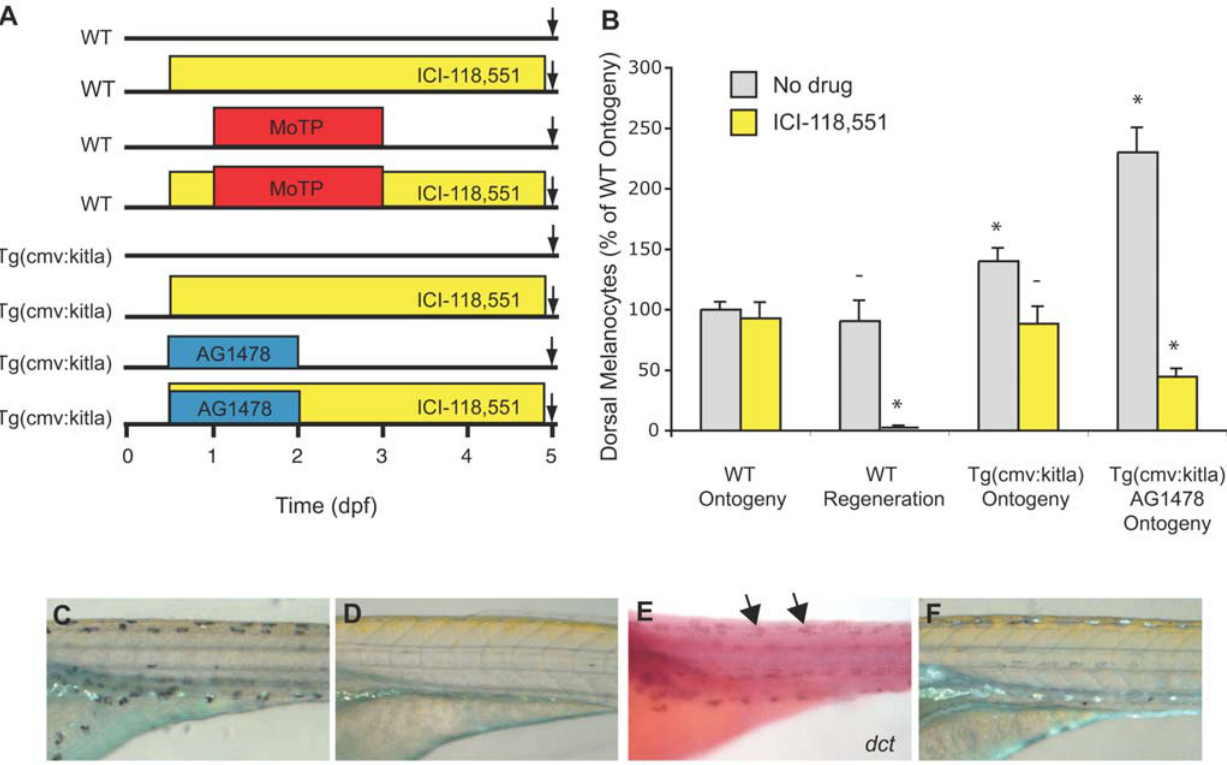
Figure 6. The regeneration specific drug, ICI-118,551, reveals that excess melanocytes in PT2hsp70:kitla larvae arise from the MSC lineage. (A) Cartoon of drug treatment timeline. (B) Quantitative data for ontogeny and regeneration represented as percentage of WT melanocyte numbers. Error bars show standard deviations, * P , 0.05, - P . 0.05 (Student’s t-test, N . 7). (C) WT larvae treated with ICI-118,551 develop faintly melanized ontogenetic melanocytes, in contrast to (D) failure to develop melanized melanocytes when challenged to regenerate in the presence of ICI-118,551. (E) In situ analysis reveals regeneration proceeds to the dct + melanoblast stage (arrows) in the presence of ICI-118,551. (F) ICI-118,551 treated PT2hsp70:kitla embryos develop similar numbers of faintly melanized melanocytes as ICI-118,551 treated embryos shown in (C). Differences in iridophore appearance between (C) and (F) are results of slightly different illumination conditions.